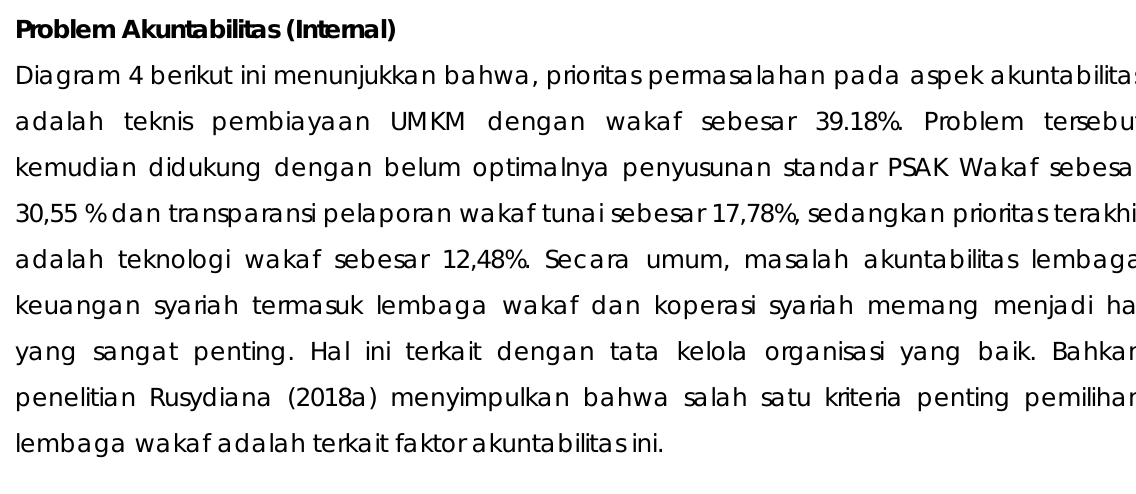
Diagram 3. Problem SDM